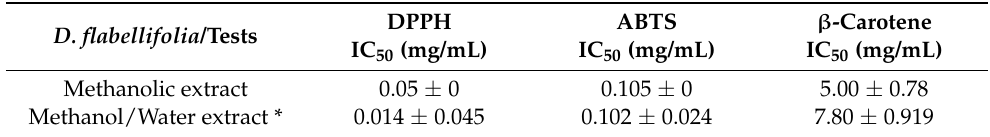
Table 7. Comparison between D. flabellifolia methanolic and methanol/water extract antioxi- dant